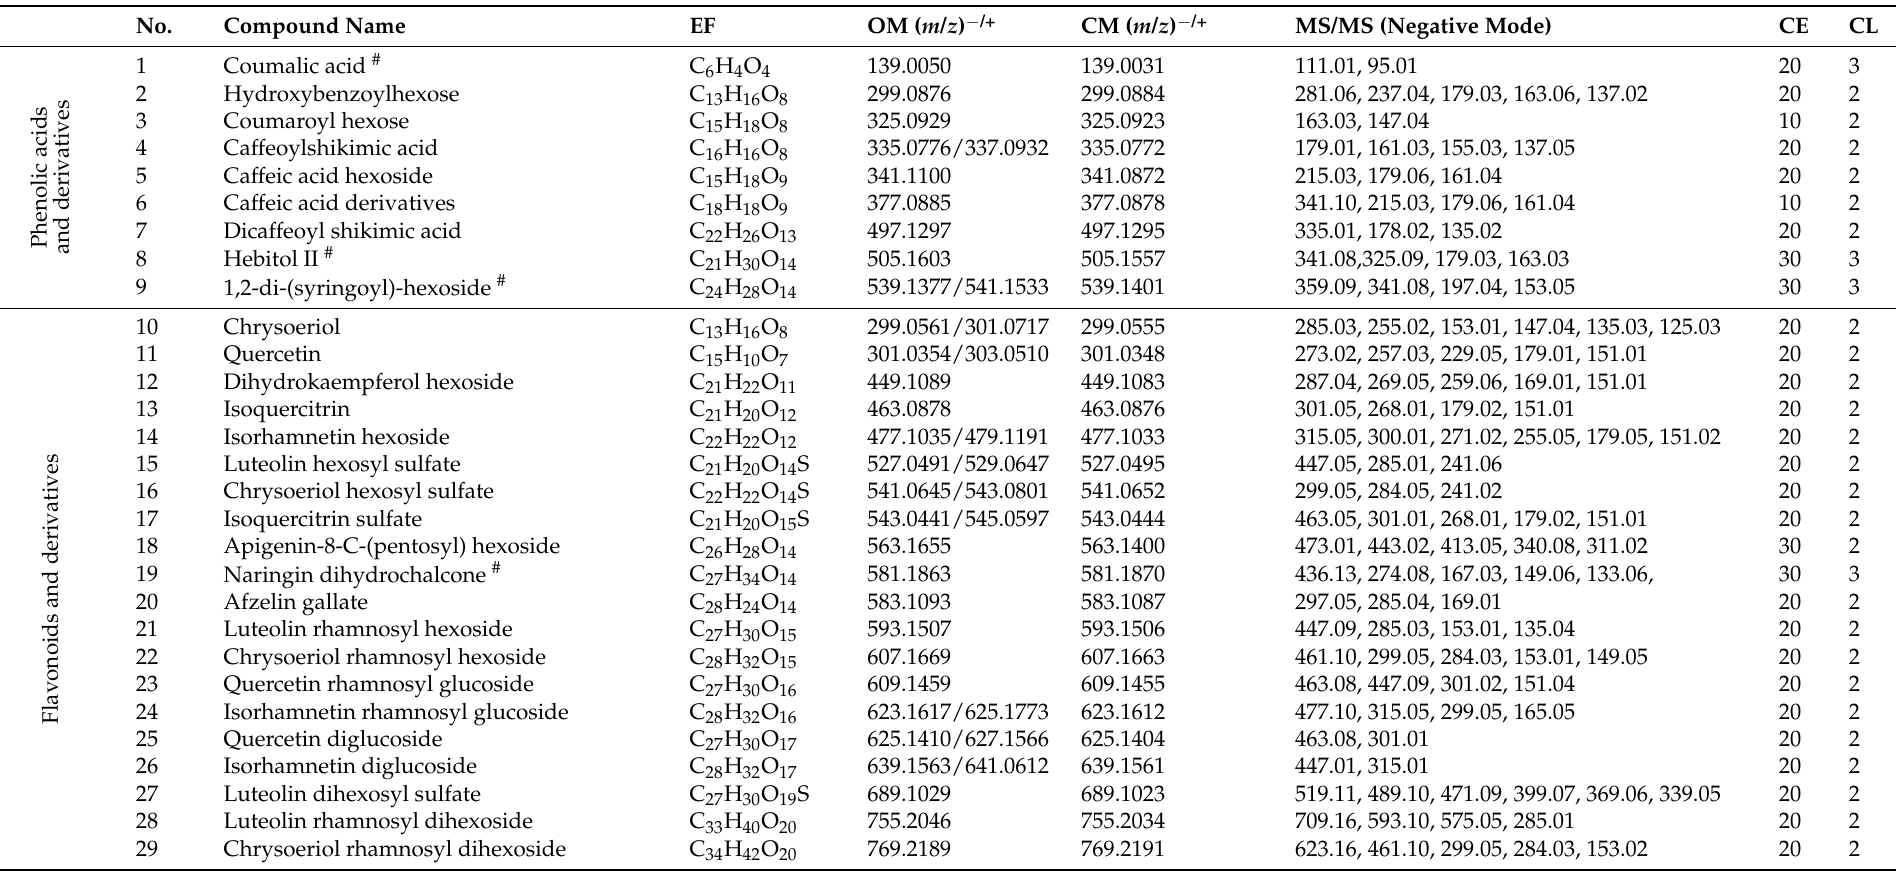
Table 5. List of possible identified compounds of the optimized extract of ripe Ajwa date pulp (RADP) by electrospray ionization mass spectrometry (ESI-MS)/MS.